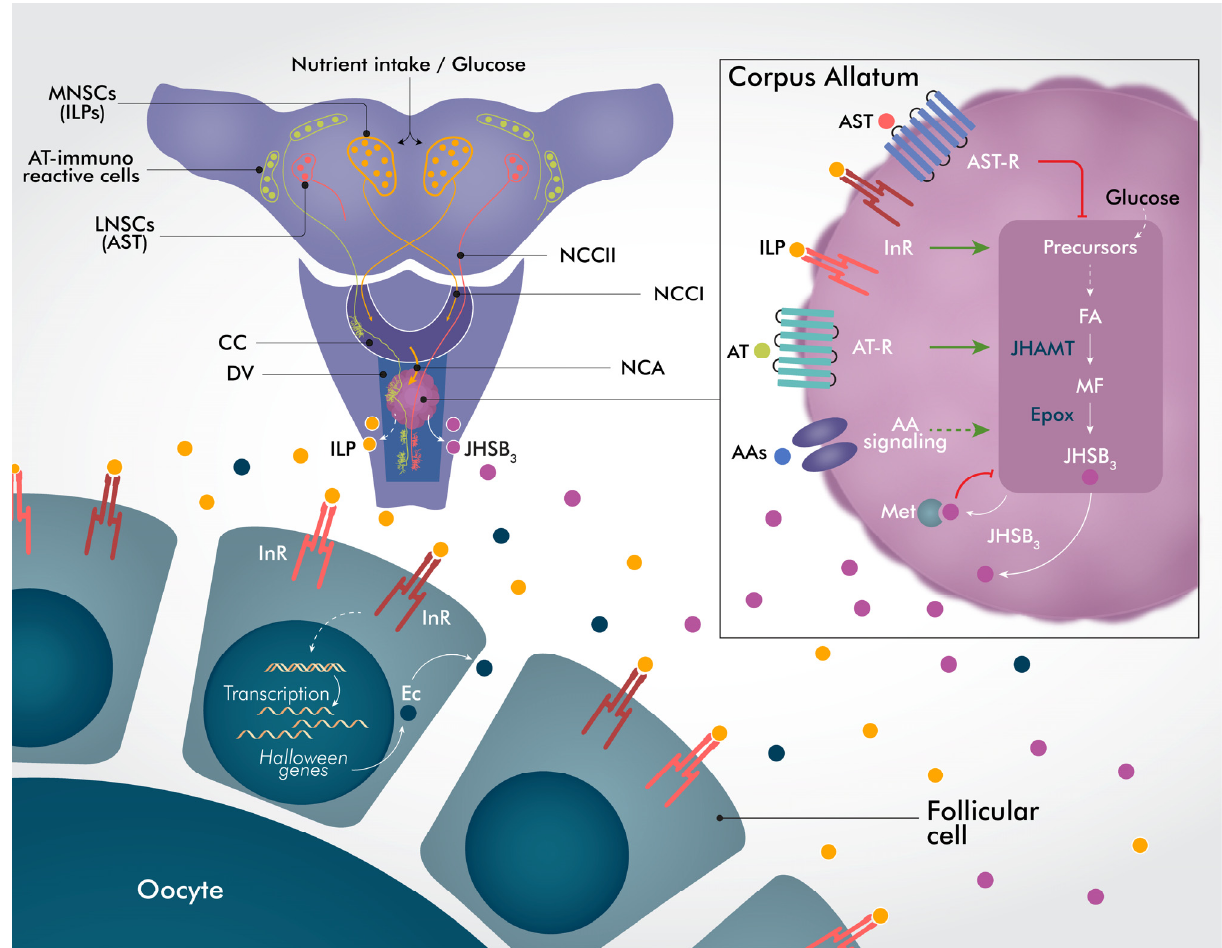
Figure 8. Insights into the crosstalk between nutrition, insulin, juvenile hormone, and ecdysteroid signaling for successful reproduction in R. prolixus females. After a blood meal, ILPs stored in the MNSCs are released from processes in the CC and CA. In the CA, ILPs stimulate expression of JH biosynthetic enzymes, and thus JHSB 3 production. JH production and release is also likely regulated by two important classes of neuropeptides. Neurosecretory cells containing ATs and others containing ASTs have axons that exit the brain via the NCCII delivering peptides that can stimulate (ATs) or inhibit (ASTs) CA activity. Once circulating, JHSB 3 acts via Met as a JH sensor through a negative feedback loop, directly modulating the transcription of its own biosynthetic enzymes. A potential role of AA signaling to stimulate JH production after a blood meal is also proposed. Moreover, glucose might modulate JH production by stimulating the release of ILPs from the brain (ILPs might also influence AT/AST release) or working as a source of precursors for JH synthesis. Interestingly, JHAMT and Epox appear to be the enzymes most regulated. Insulin, in turn, stimulates ecdysteroid synthesis in the ovary by increasing transcript expression of Halloween genes , and ecdysteroid release into the hemolymph. Together, these coordinated actions lead to a successful reproductive cycle. JHSB 3 , JH III skipped bisepoxide; AST, an FGLa/allatostatin type A; AT, allatotropin; JHAMT, Juvenile hormone acid methyltransferase; Epox, Methyl farneseoate epoxidase; ILPs, insulin-like peptides; AT-R, allatotropin GPCR; AST-R, allatostatin GPCR; InR, insulin receptors; CC, corpus cardiacum; NCCI, nervus corpus cardiacum I; NCCII, nervus corpus cardiacum II; NCA, nervus corpus allatum; LNSC, lateral neurosecretory cell; MNSCs, median neurosecretory cells; Ec, ecdysteroids; DV, dorsal